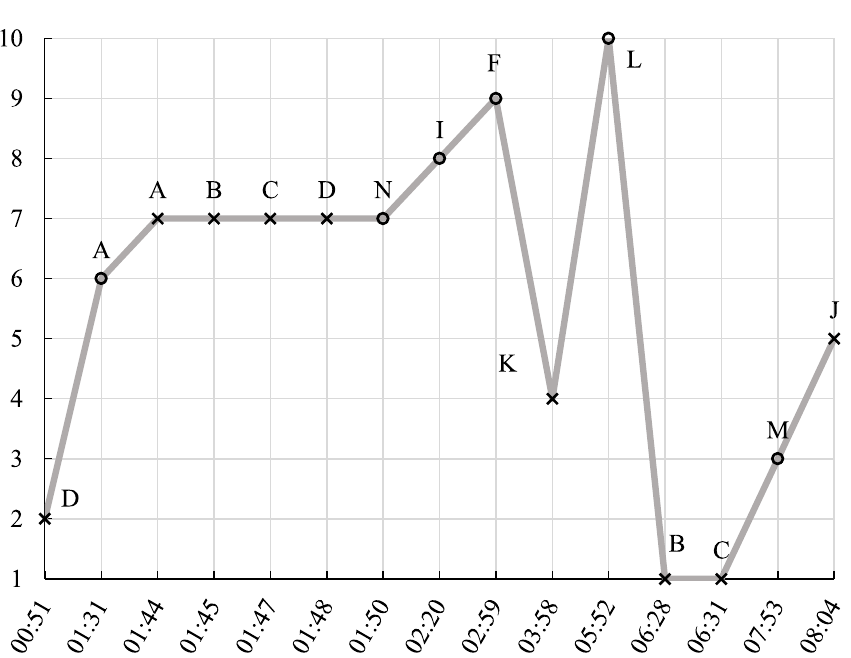
Fig. 2 DX’s (upper) and FF’s (lower) choice-making processes for